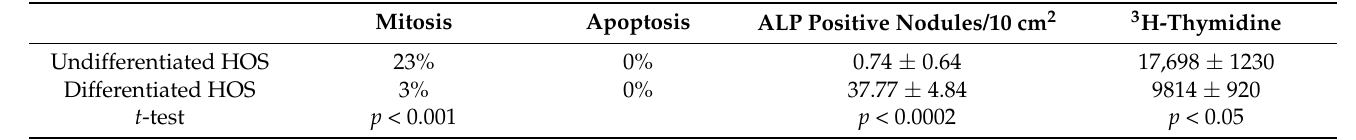
Figure 1. Differentiated and undifferentiated HOS: alkaline phosphatase staining of ( A ) undifferentiated HOS and ( B ) differentiated HOS (blue staining of nodules indicate alkaline phosphatase positive cells); DAPI staining of ( C ) undifferentiated HOS and ( D ) differentiated HOS (arrows point to the mitotic cells). Table 1. Characterization of undifferentiated and differentiated cell cultures.